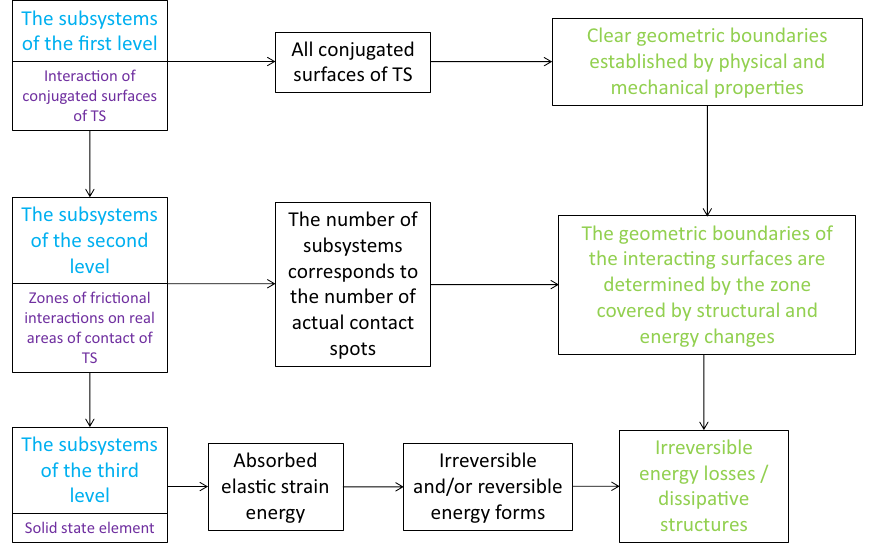
Figure 1. The hierarchy of subsystems of three levels in TS of diesel